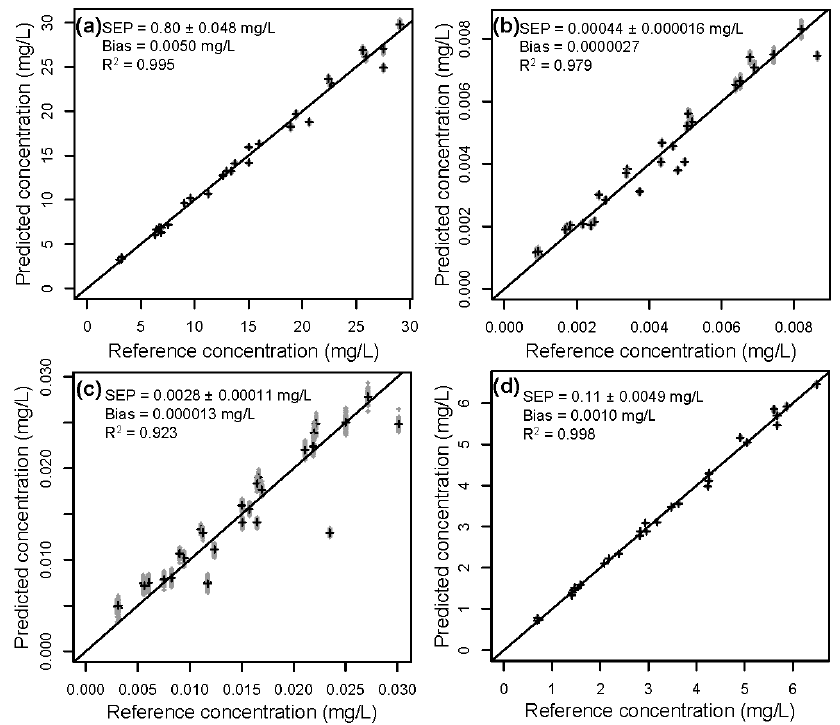
Figure 6. Reference concentration vs. predicted concentrations of ( a ) lignin, ( b ) HMF, ( c ) furfural, and ( d ) acetic acid in Block 4 obtained by rdCV, using raw data. In gray are the results from the 50 repetitions in rdCV (very close together and therefore mostly hidden), and in black are the means of 50 predictions.